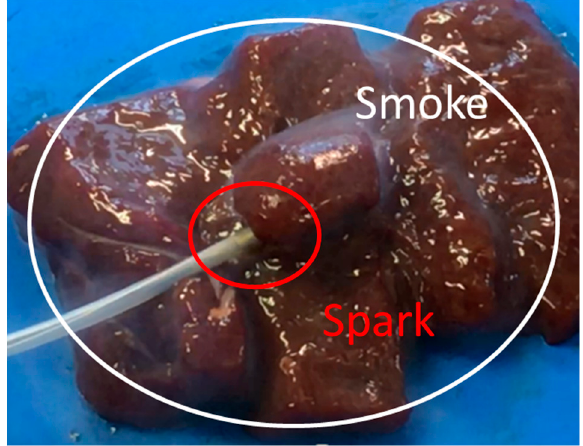
Figure 13. Heating with the high frequency current snare. Diagnostics 2018 , 8 , x FOR PEER REVIEW